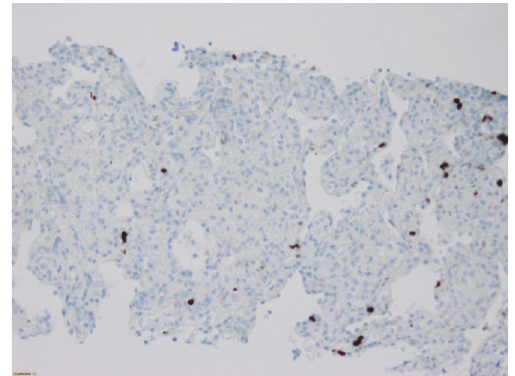
Figure 5: Neuroendocrine lung tumor biopsy with < 2% Ki-67 proliferation